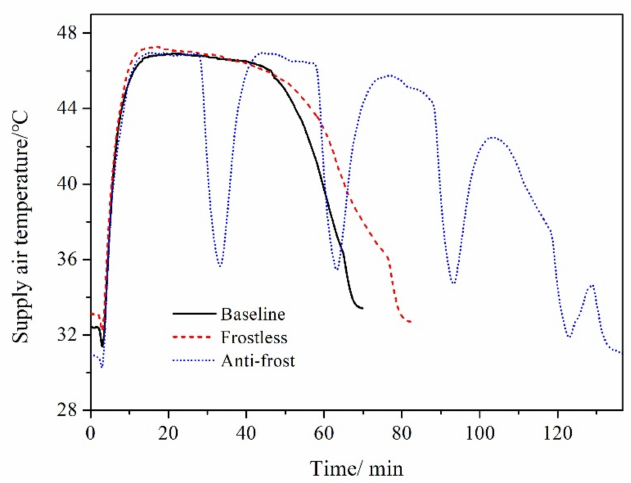
Figure 6. Supply-air temperature during frosting/defrosting cycles for the three modes.